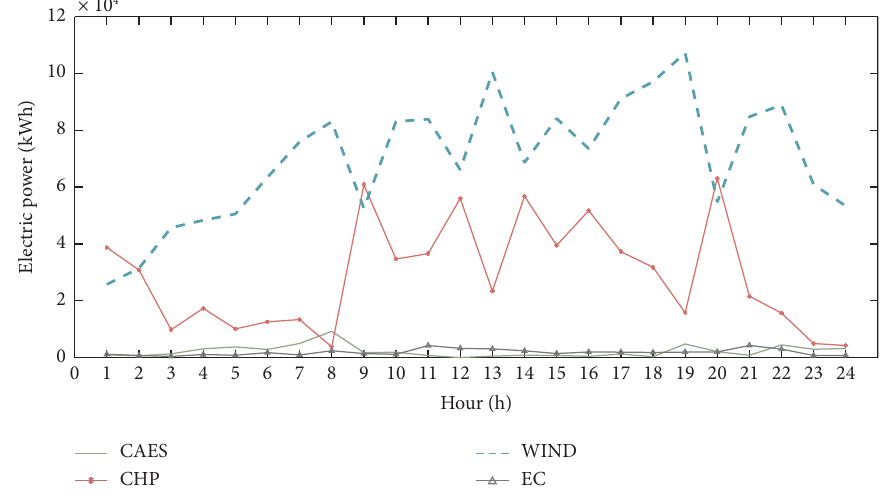
Figure 16: Power dispatch in spring/autumn.